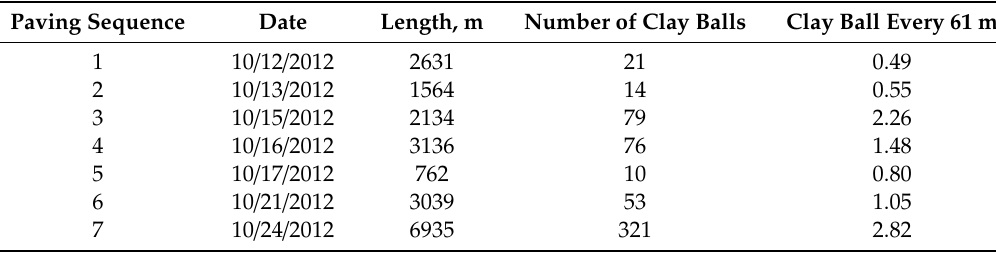
Table 3. Summary of project information.